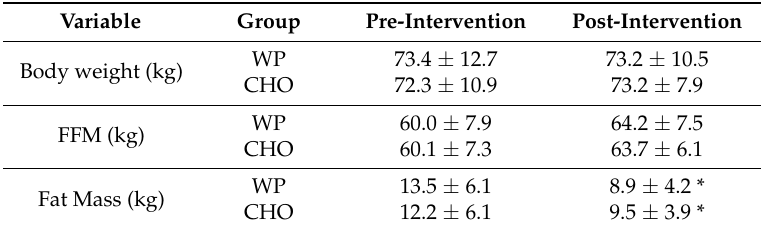
Table 2. Summary of body composition during IET.